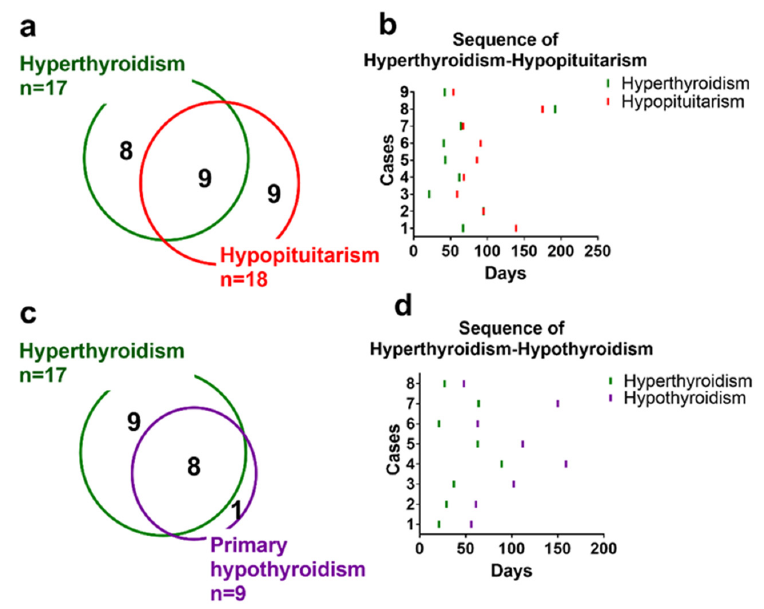
Figure 4. Co-occurrence of endocrine irAEs. Co-occurrences and sequences of hyperthyroidism with hypopituitarism ( a , b ) and primary hypothyroidism ( c , d ).